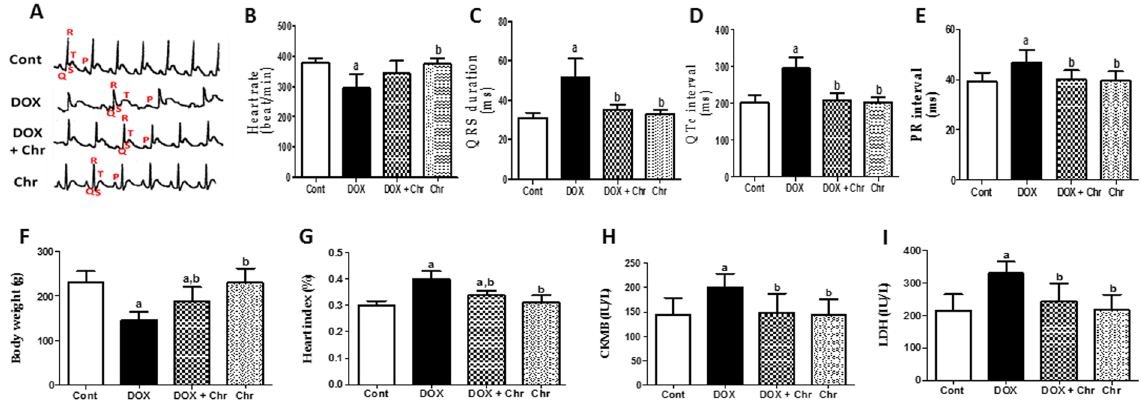
Figure 1. Effect of chrysin on ECG pattern, body and heart weight, and cardiotoxicity markers in rats subjected to chronic doxorubicin (DOX) intoxication. ( A ) ECG graph. ( B ) Heart rate (beat/min), ( C ) QRS duration (ms), ( D ) QTc interval (ms) ( E ) PR interval (ms). ( F ) Body weight (g), ( G ) Heart index (%), ( H ) CKMB activity (IU/L). And ( I ) LDH activity (IU/L). Data are represented as mean ± SD (n = 10). a or b: Statistically significant from the control or DOX group respectively at P < 0.05 using one-way analysis of variance ANOVA followed by Tukey-Kramer as a post-hoc